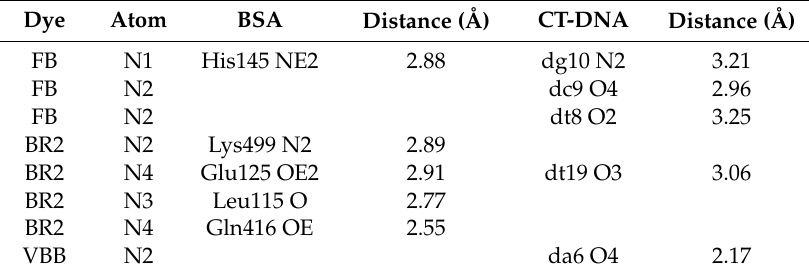
Figure 7. The most stable conformations between BSA and dyes ( a ) FB, ( b ) BR2 and ( c ) VBB based on the lowest free binding energy. Table 2. The hydrogen bonds of dyes with BSA and CT-DNA.